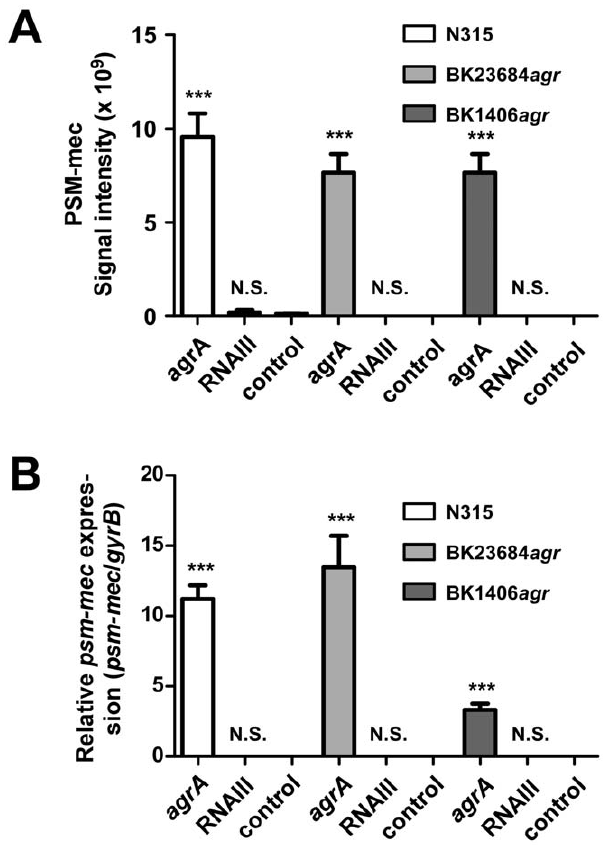
Figure 3. Mechanism of Agr-dependent regulation of psm-mec . Expression of psm-mec on the protein (A) and transcript (B) levels was analyzed in the psm-mec -positive, Agr-dysfunctional MRSA strains N315 (SCC mec type II), BK1406 agr (SCC mec type III), and BK23684 agr (SCC mec type VIII), in which the agrA gene or RNAIII were constitutively over- expressed using plasmid pTX D (in strain N315) or expressed using induction with 0.5% xylose in a pKX background (in the other 2 strains). Control, containing the empty plasmid pTX D 16 or pKX16, respectively. (A) Protein level analysis. (B) Transcript level analysis. Relative expression of the psm-mec transcript is shown, relative to expression of the housekeeping gene gyrB . N.S., not significant; ***, p , 0.0001; One-way analysis of variance with Dunnett post tests compared to the control sample.